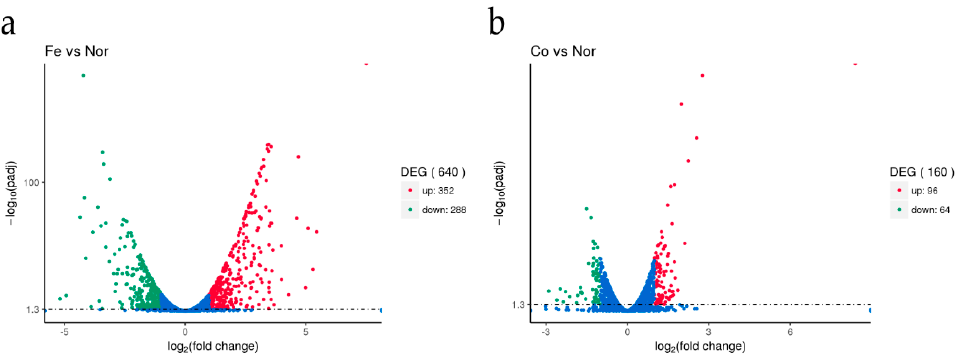
Figure 1. The S. suis transcriptome was altered in response to ferrous iron and cobalt toxicity. S. suis was grown to an OD 600 of 0.6, and treated for 15 min with 2 mM FeSO 4 , 0.25 mM CoSO 4 or deionized water. The figures show the transcription profiles of S. suis in the presence of either ferrous iron ( a ) or cobalt ( b ) compared to water. Fe, Co, and Nor in the figures represent ferrous iron, cobalt, and water treatment, respectively. DEG, up, and down represent the differentially expressed genes, up-regulated genes (in red color), and down-regulated genes (in green color), respectively. Genes with a fold change > 2 and an adjusted p -value (padj) < 0.05 were defined as differentially expressed genes.